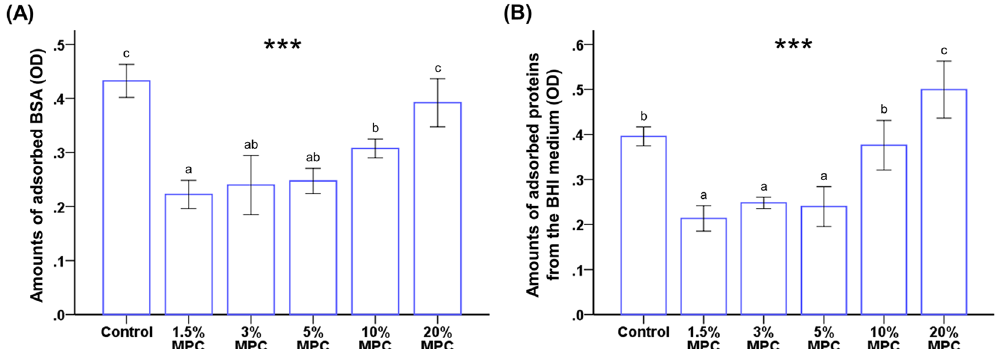
Figure 2. Comparison of the optical density (OD) of adsorbed bovine serum albumin (BSA) ( A ) and protein adsorbed form brain heart infusion (BHI) medium ( B ) between LCFV with different concentrations of MPC. Different letters above bars indicate significant differences. *** P < 0.001 for comparisons between LCFV with different concentrations of